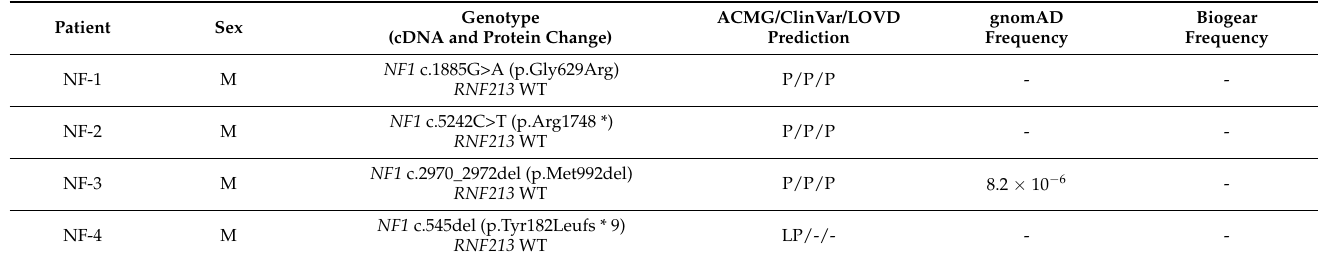
Table 3. NF1 and RNF213 rare variants identified in NF1